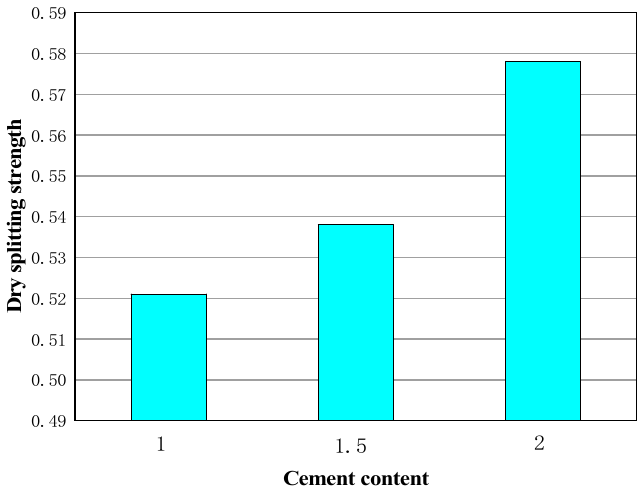
Figure 9. Strength of di ff erent cement doses.